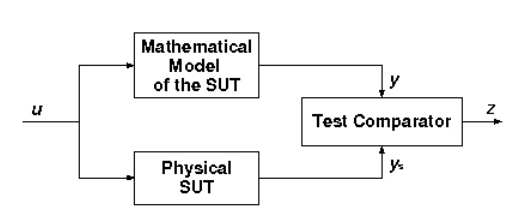
Figure 2. Testing with a model as an